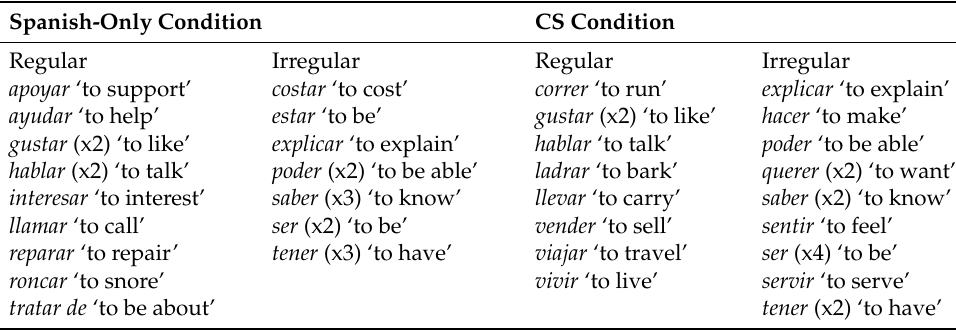
Table 1. List of verbs used in the materials (repetitions in